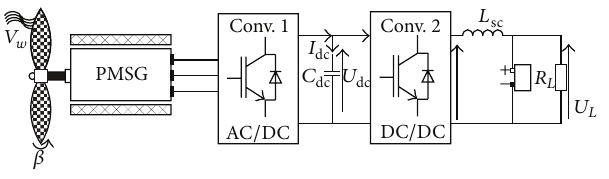
Figure 1: Standalone wind power generation system.